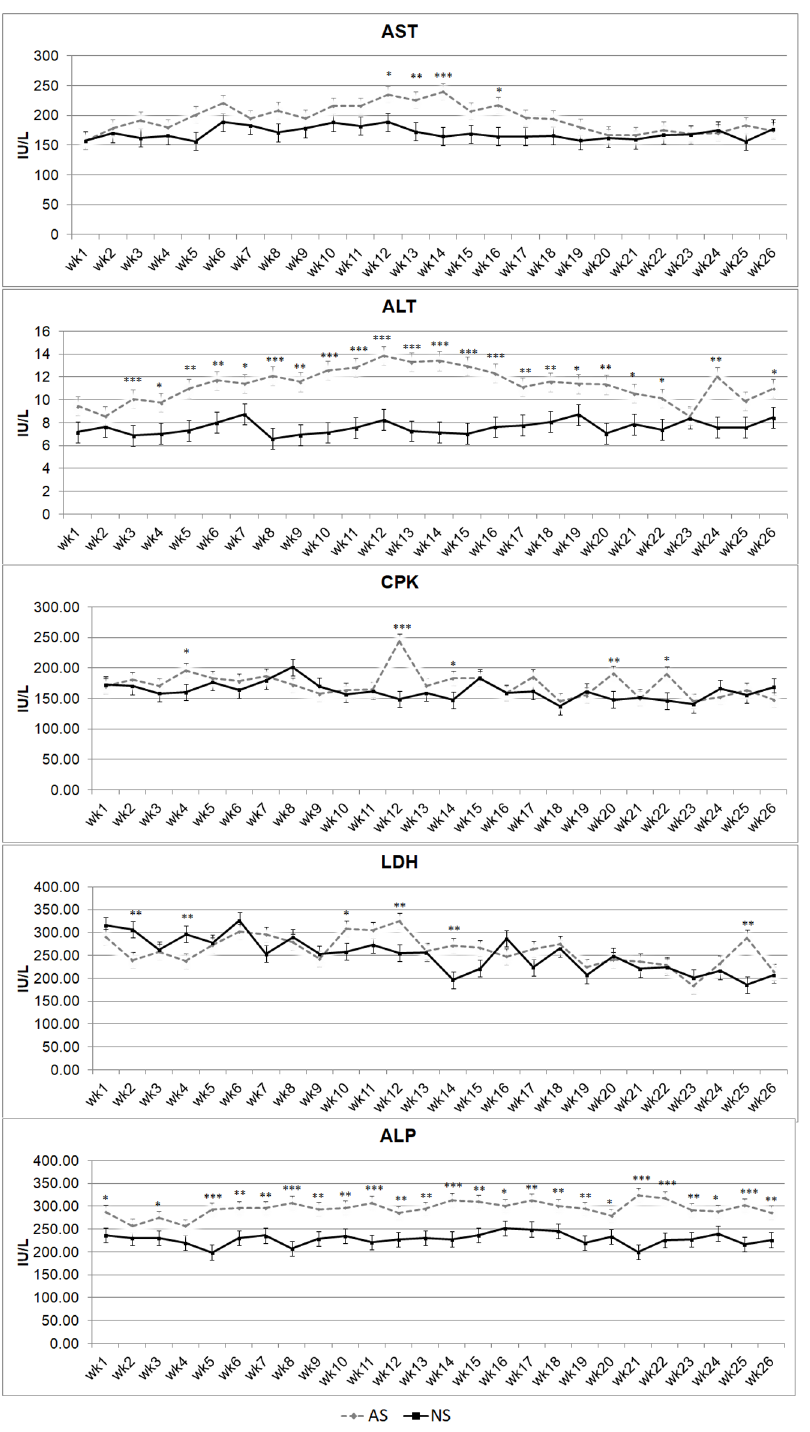
Fig 3. Alanine aminotransferase (ALT), aspartate aminotransferase (AST), creatine phosphokinase (CPK), lactate dehydrogenase (LDH) and alkaline phosphatase (ALP) serum concentrations in artificially-suckled(AS) and naturally-suckled (NS) donkey foals during the first 26 weeks of life. (Values are Least Square Means; bars represents Standard Error of the Mean). Statistical differences between the two groups at the same week were expressed: (cid:3) = P < 0.05; (cid:3)(cid:3) = P < 0.01; (cid:3)(cid:3)(cid:3) = P < 0.001.